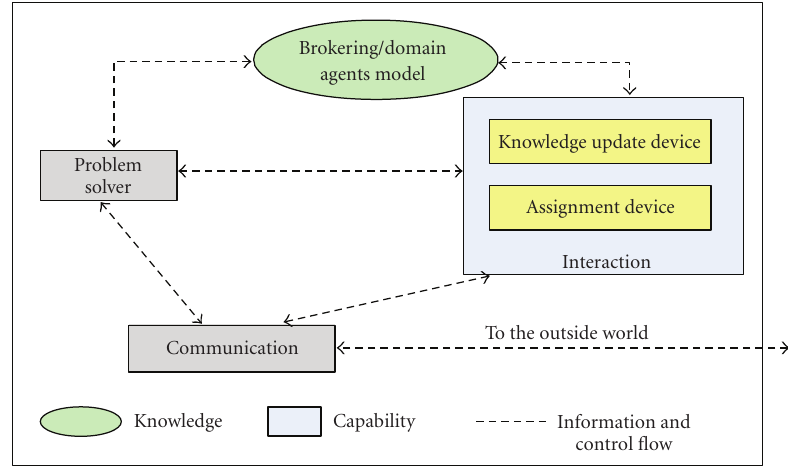
Figure 13: The brokering agent